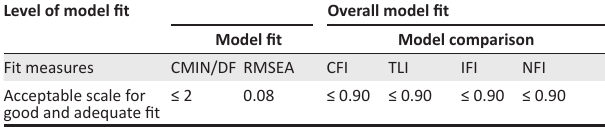
TABLE 3: Fit indices reported in this